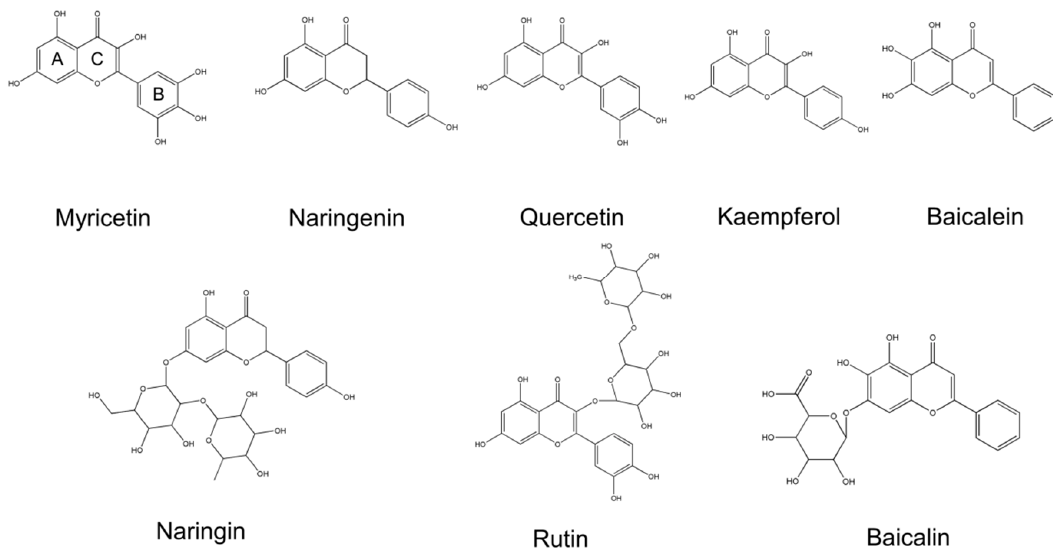
Figure 1. The chemical structures of flavonoids tested in this study.